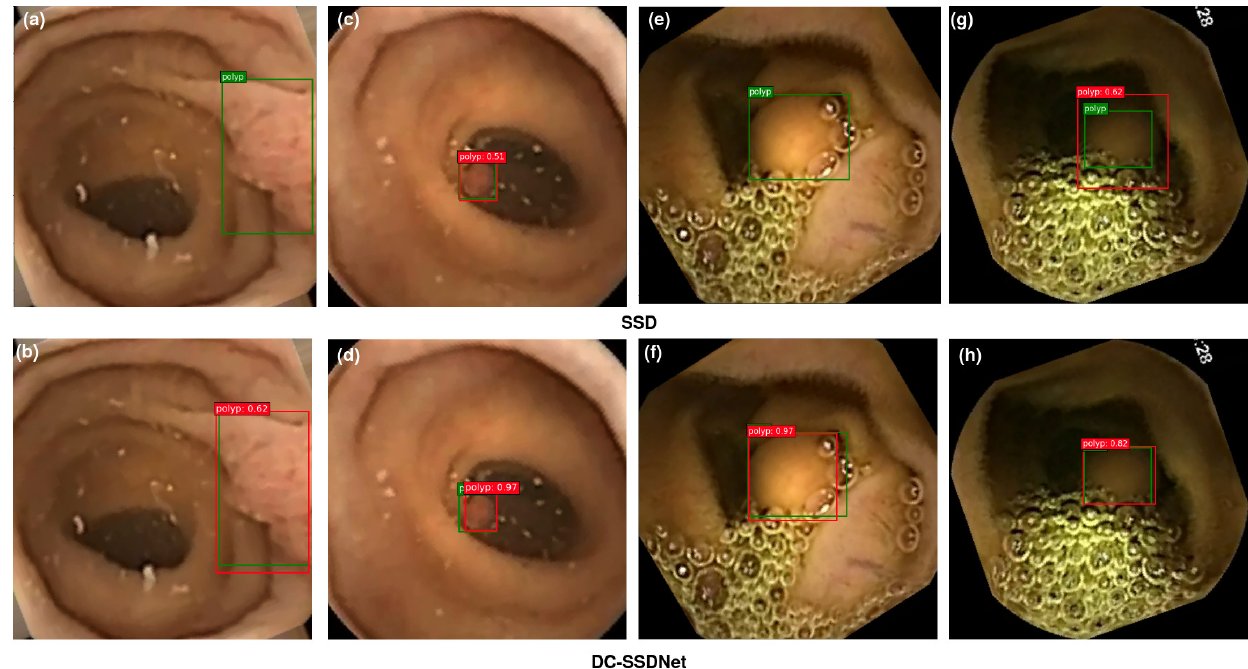
Figure 8. On the WCE test set, visualization results comparing SSD300 ( a , c , e , g ) and the proposed DC-SSDNet network ( b , d , f , h ). True bounding boxes with IoU of 0.5 or greater are drawn in green, whereas predicted bounding boxes are in red.